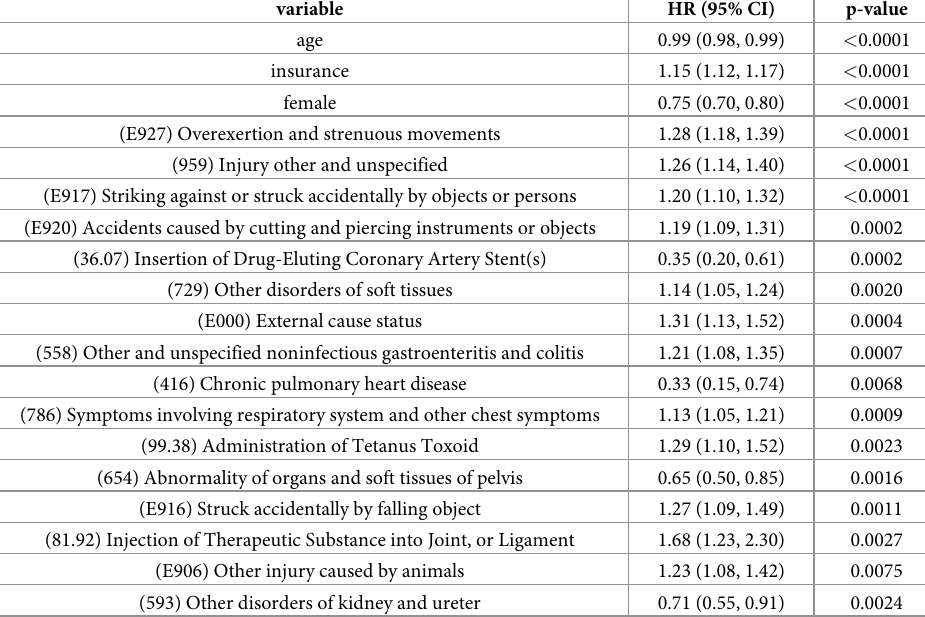
Table 6. Predictors of WPI recurrence as selected by stepwise Cox